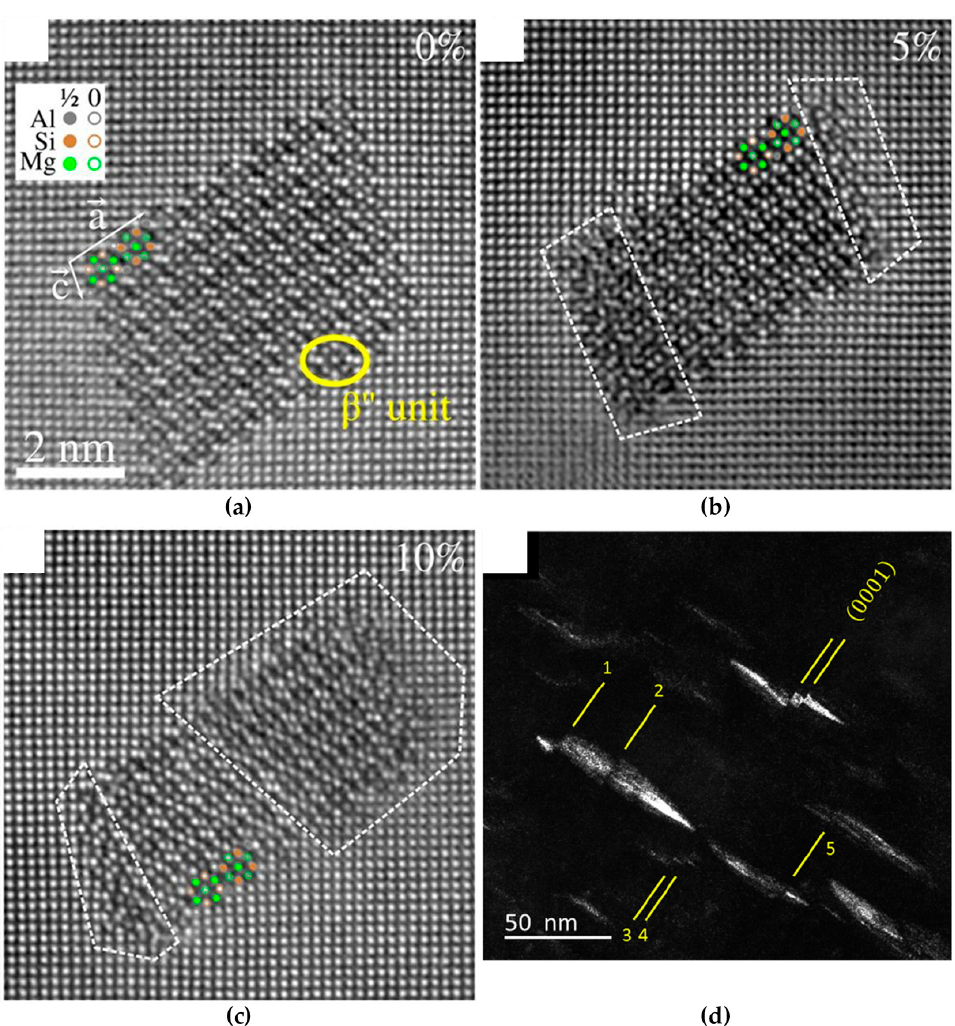
Figure 21. TEM images of shearing interactions. ( a – c ) Images of a particle partially sheared by dislocations at compressive engineering strains of 0%, 5% and 10%, respectively; ( d ) Image of particles sheared by arrays of dislocations. (Reprinted from References [114,117], with permission from Springer Nature and Elsevier).